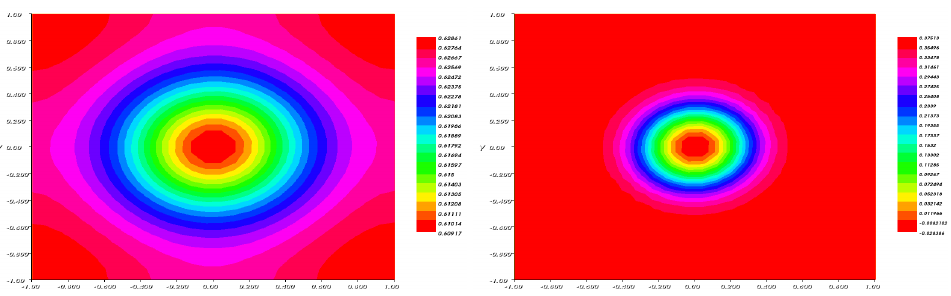
Figure 12. The fraction ϕ ( left ) and ψ ( right ) after T = 30.